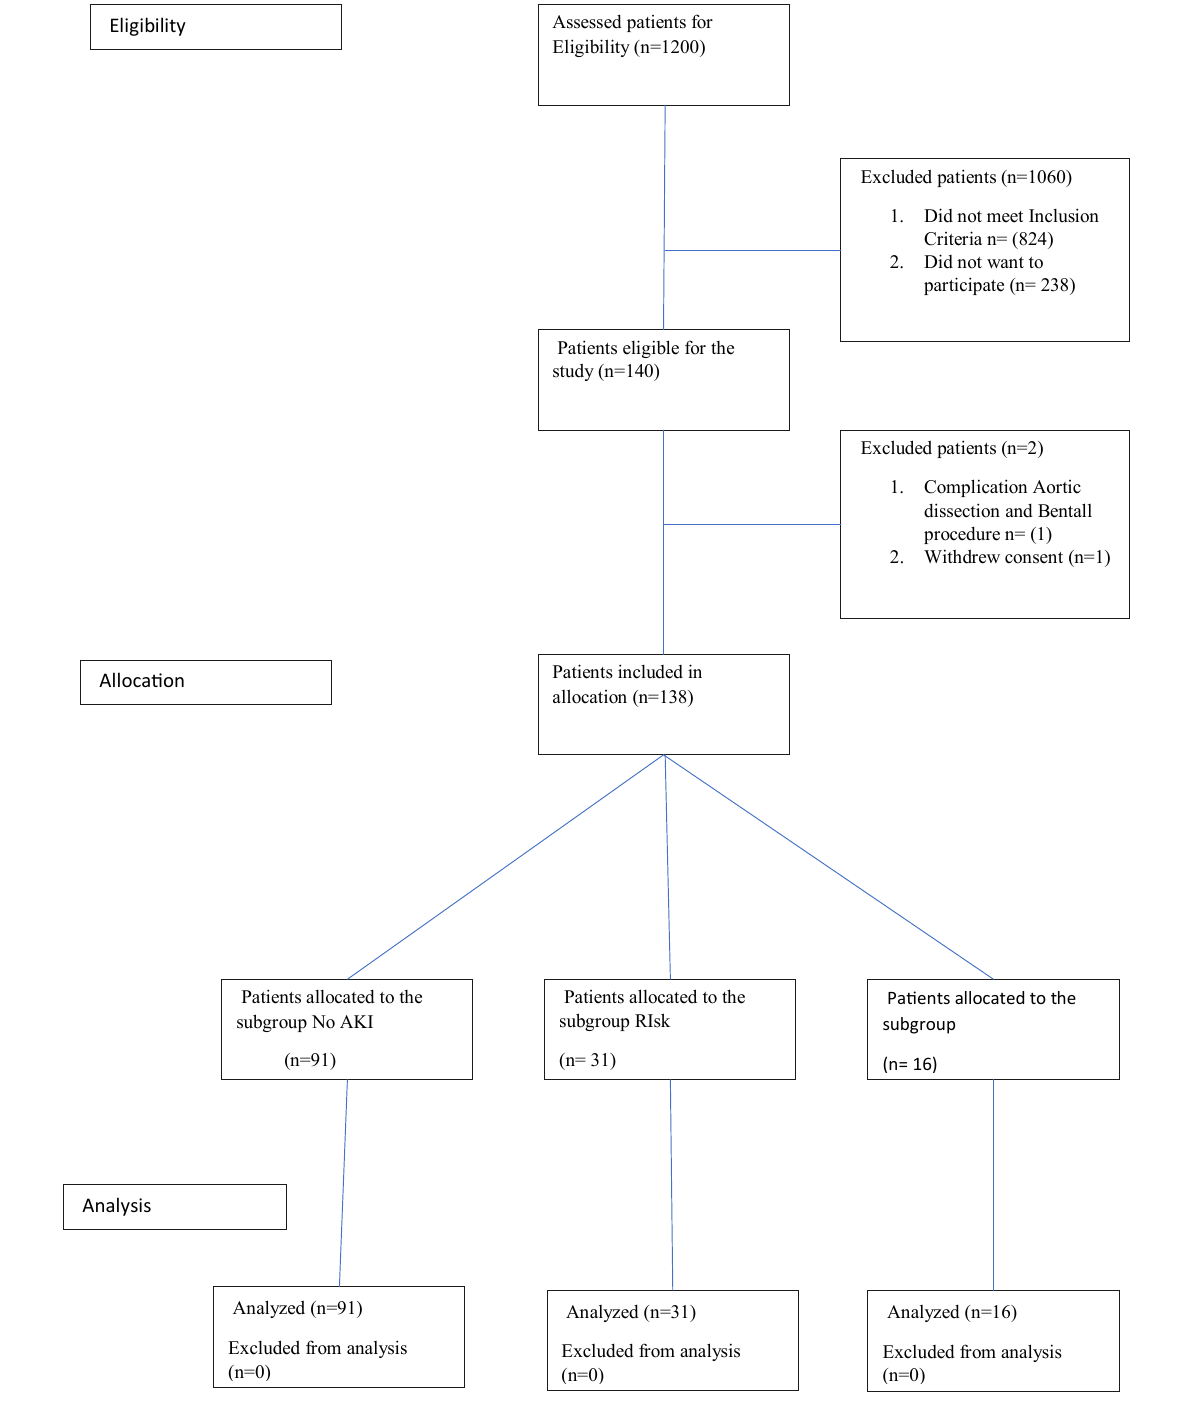
FIGURE1 CONSORT diagram: flow diagram graphically describes the design of the study: enrollment, allocation, and data analysis.